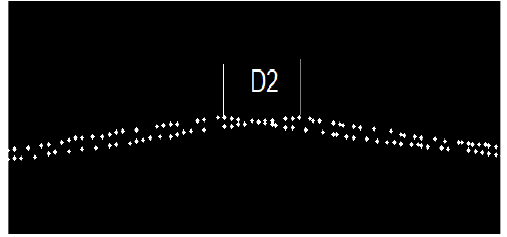
Figure 6. Pitch results in the displacement of the same name point